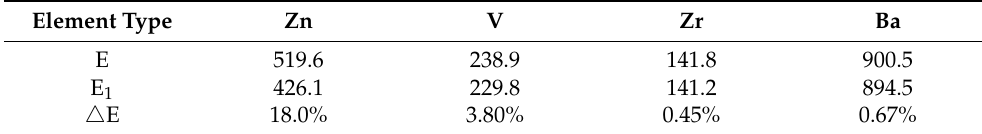
Table 7. Comparison table of content changes in samples E and E 1 (ppm).